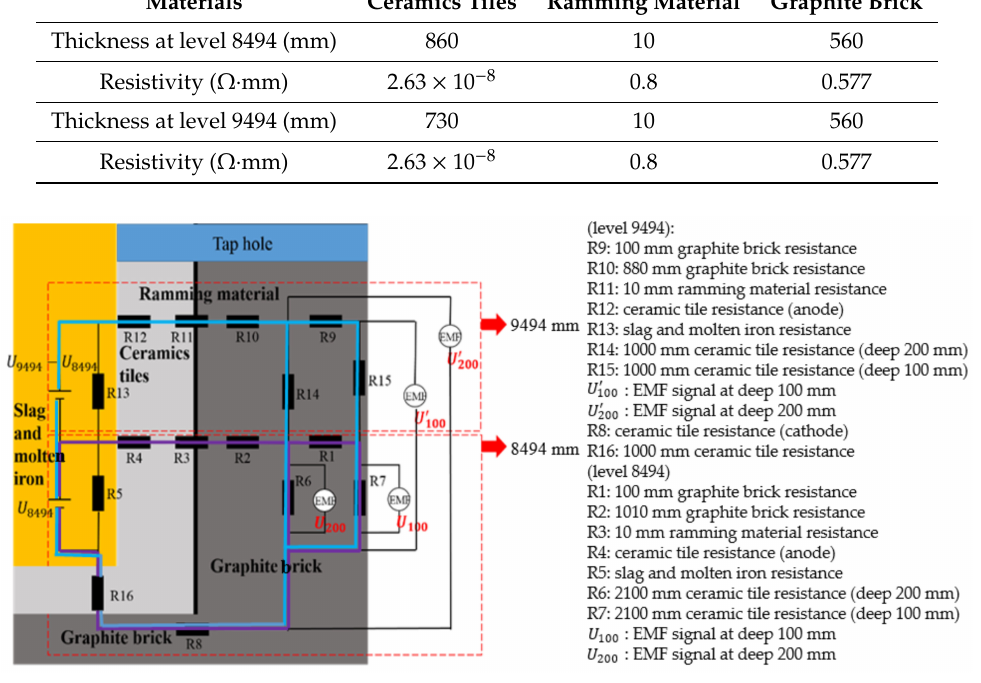
Figure 11. EMF measurement principles of the blast